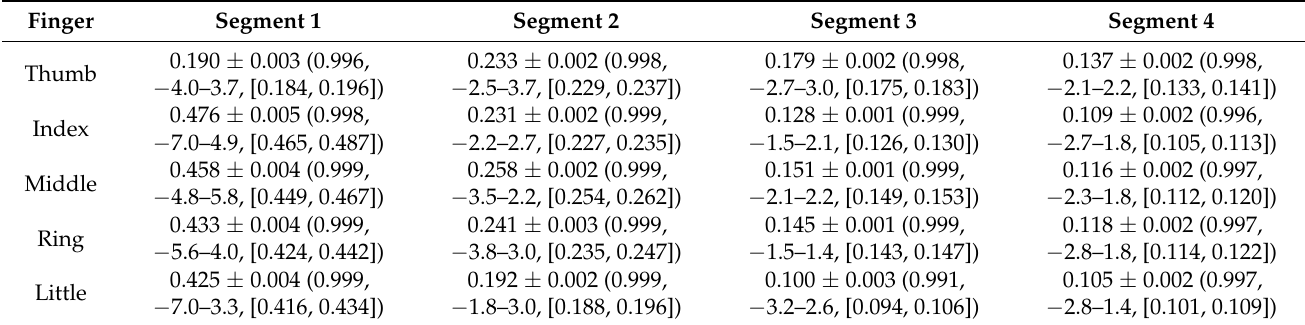
Table 2. Coefficients for estimating link length or segment length from hand length (A, where link length = A × hand length) based on 15 male hands (mean ± standard error, R 2 , maximum residual range, and 95% confidence